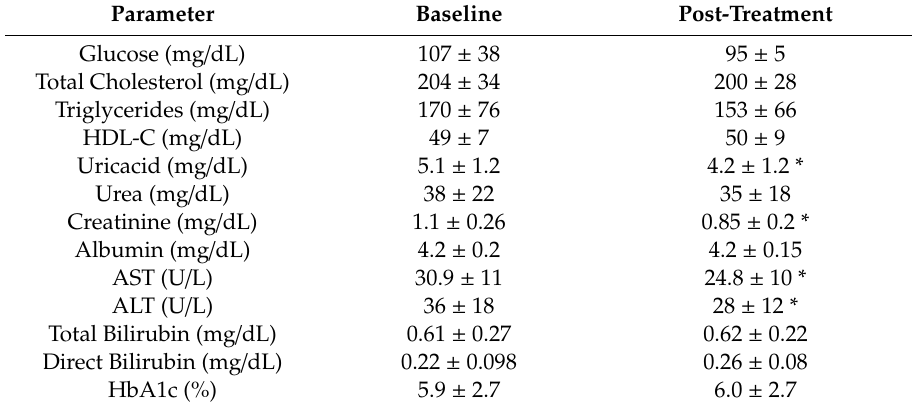
Table 2. Markers pre- and post-treatment.